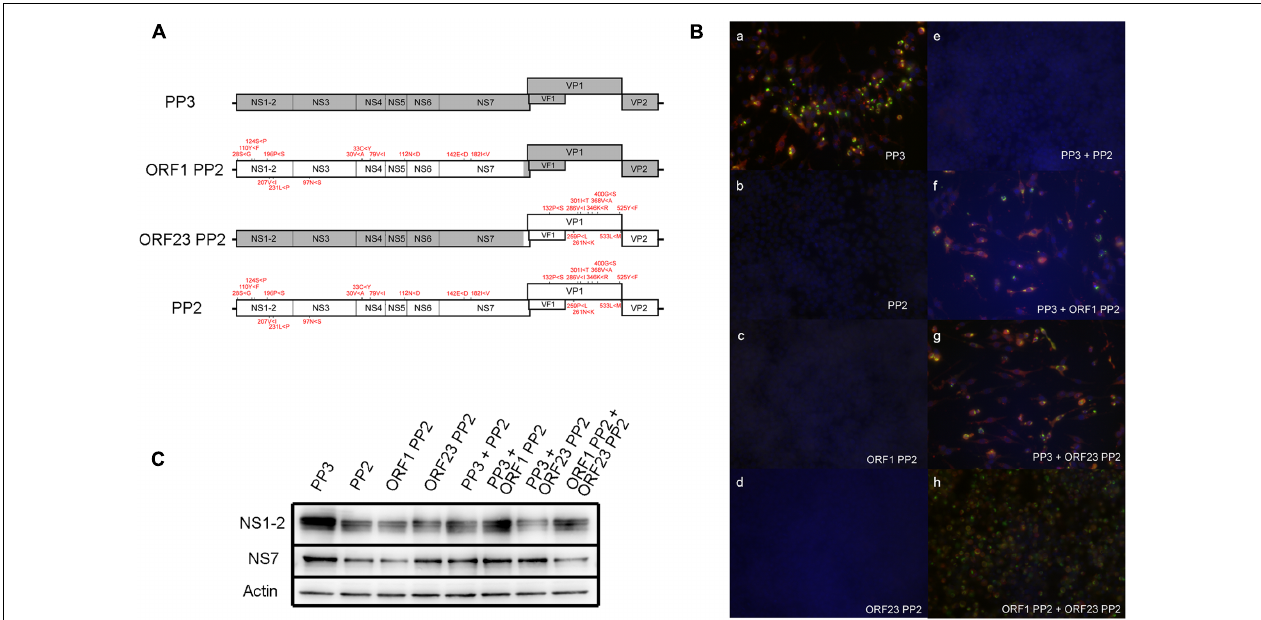
FIGURE 5 | Examination of the ability of the PP2com genome to generate infectious particles. (A) Schematic of the recombinant MuNoV genome depicting regions containing PP3 and PP2com sequences. The amino acid residues encoded by the PP2com genome that differed from those encoded by the PP3 genome are indicated in red. (B) Supernatant of transfected cells in (C) was used to infect RAW264.7 cells. At 48 hpi, cells were fixed and detected for VPg (Green) and VP1 (red) by immunofluorescent detection with staining for DNA by DAPI (Blue) (see “Immunofluorescent Staining” in Materials and Methods). (C) Detection of the ORF1 products NS1-2, NS7, and actin by Western blot from the lysates of 293T cells transfected with pMNVs expressing the respective genome. The first four sets of samples were prepared by cotransfecting 2 µ g of pT7 MNV S7 and 2 µ g each of plasmid expressing the designated recombinant MuNoV genome. The last four sets of the samples were prepared by transfecting the plasmid in combination with those expressing the respective